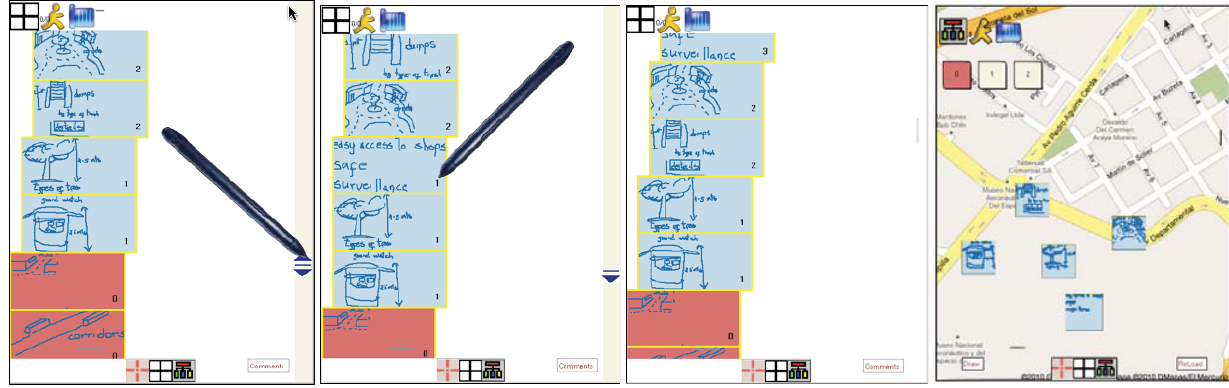
Figure 7. On the left, scrolling the ideas by moving the pen on the right border of the screen. The second and third screenshots show how a sketch can be converted in a node. At the right all ideas of level 1 were used on the knowledge creation